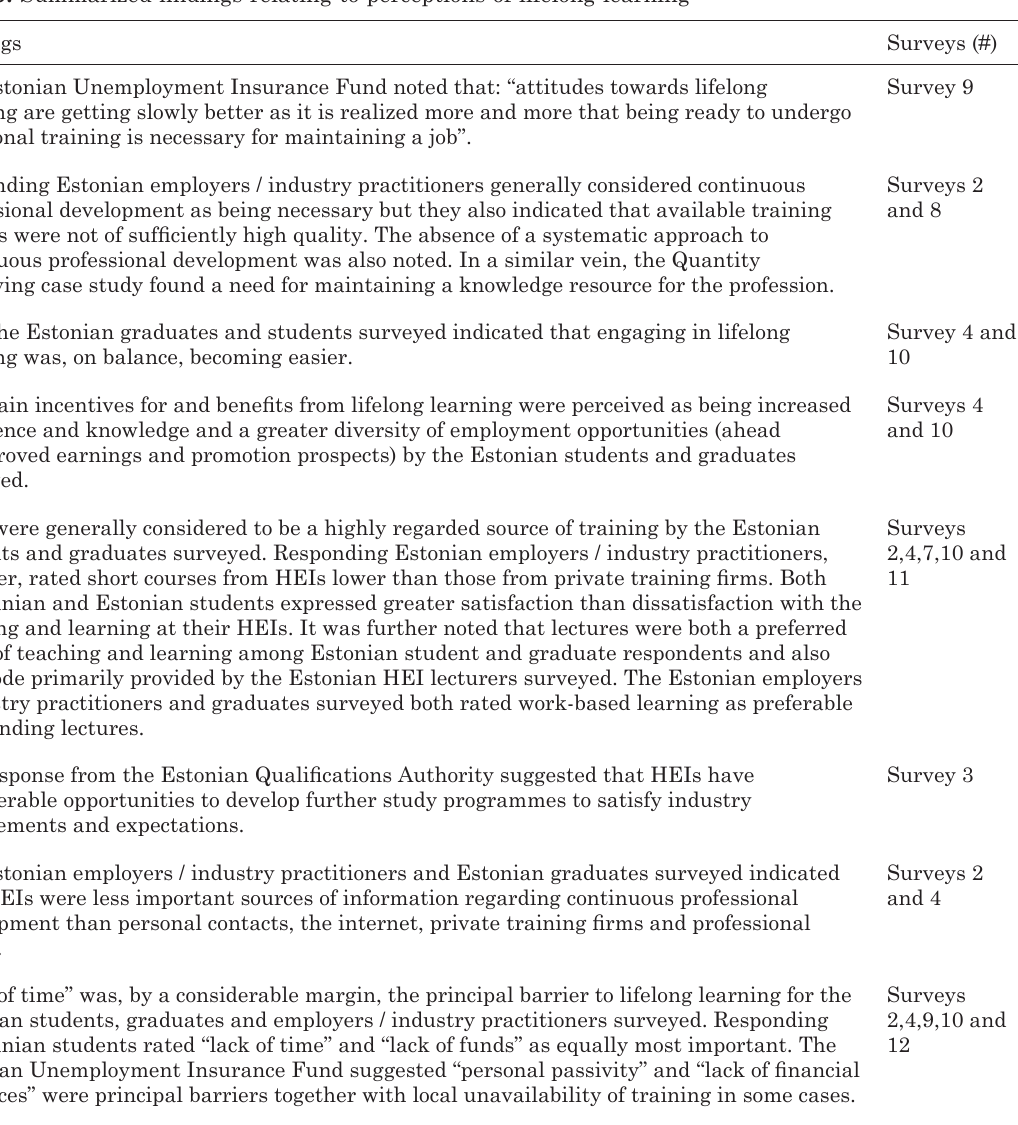
Table 5. Summarized findings relating to perceptions of lifelong